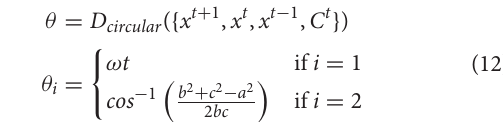
rotational matrix and the corresponding angle is assigned a